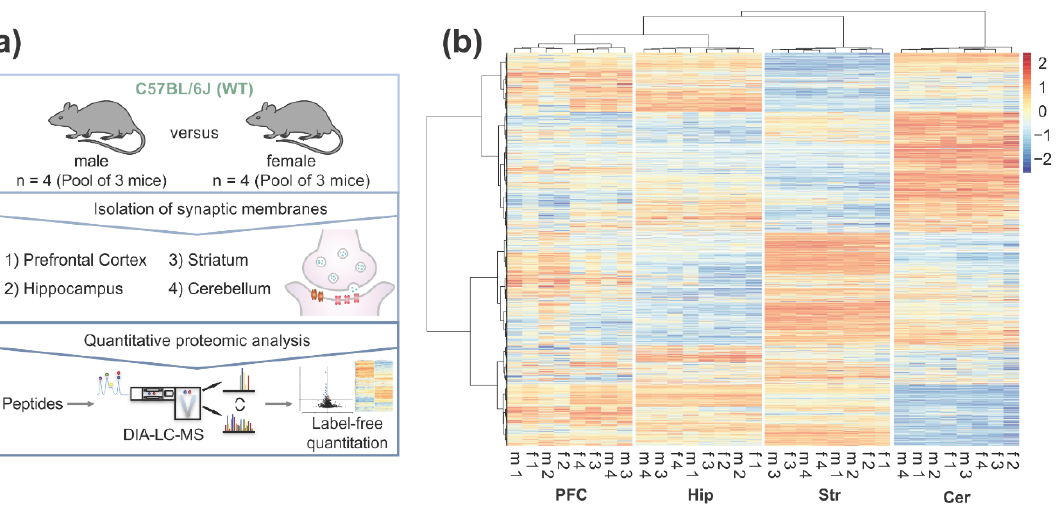
Figure 1. Quantitative LC-MS analysis of the brain region-specific synaptic proteome in male (m) and female (f) adult mice: ( a ) Graphical illustration of the workflow for the characterization of the brain region- and sex-resolved synaptic proteome; ( b ) Heatmap of all quantified proteins in the dataset. For cluster analysis and heatmap visualization, label-free quantification values were log 2 -transformed and scaled subtracting the mean of the row followed by the division of resulting values by the standard deviation of the row.